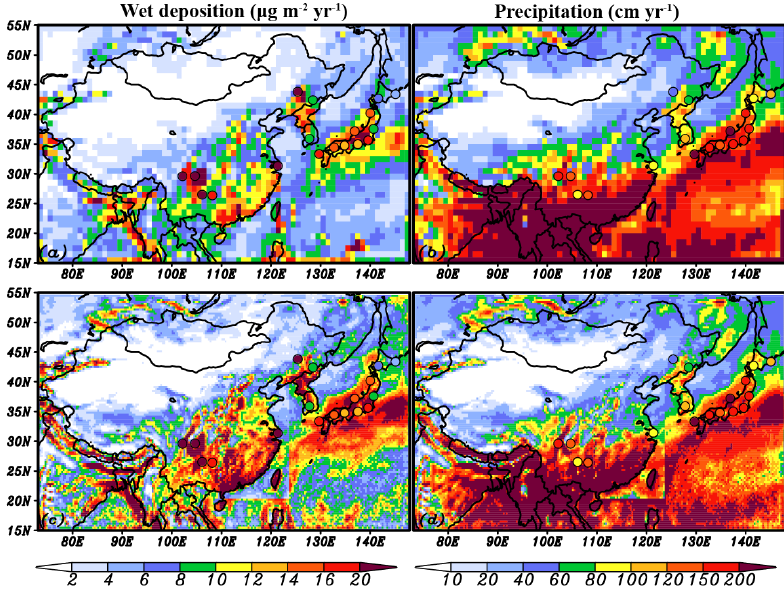
Figure 7. Simulated annual mercury wet deposition (µgm − 2 yr − 1 ) and accumulated precipitation (cmyr − 1 ) over East Asia in the global (a, b) and nested (c, d) domains in 2001. Overlaid points show observations collected from the literature. Note that observations and simulated results are not in the same year